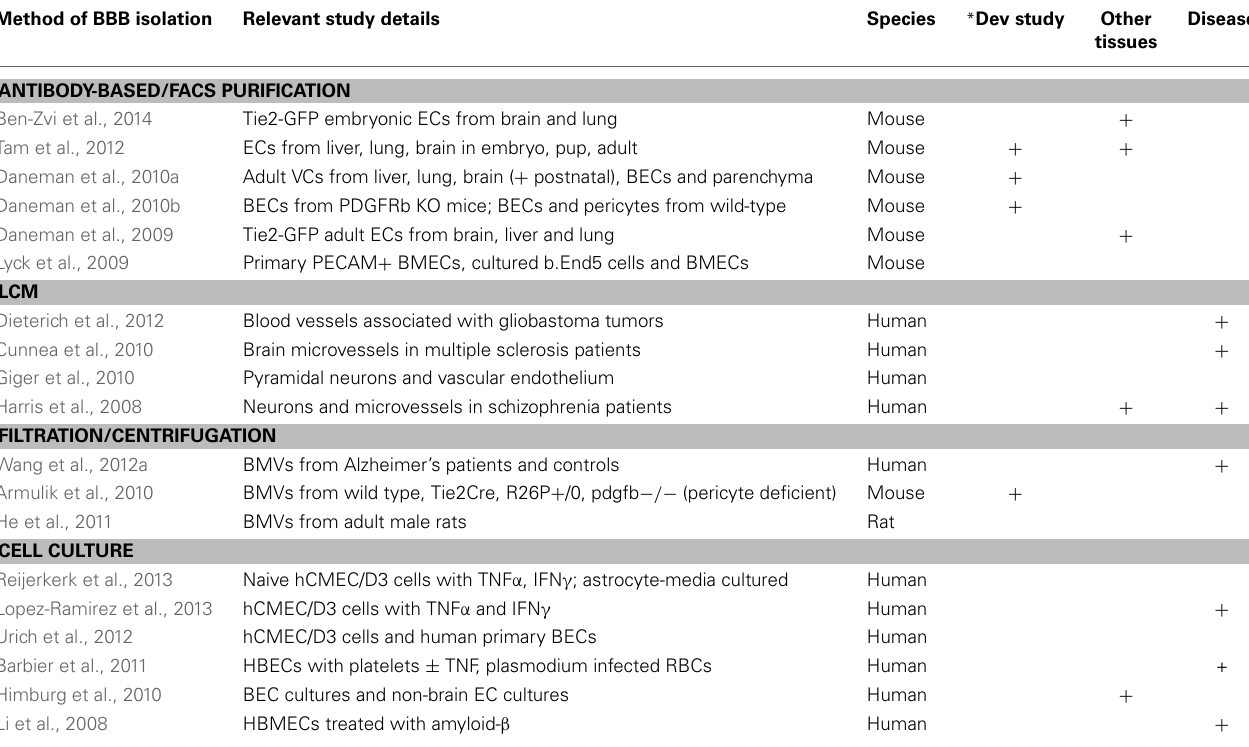
Table 1 | Recent genomewide microarray expression data sets for the